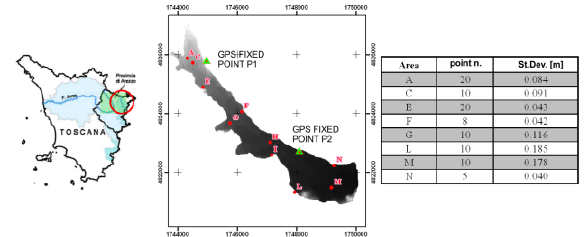
Figure 1. Check points position in the test